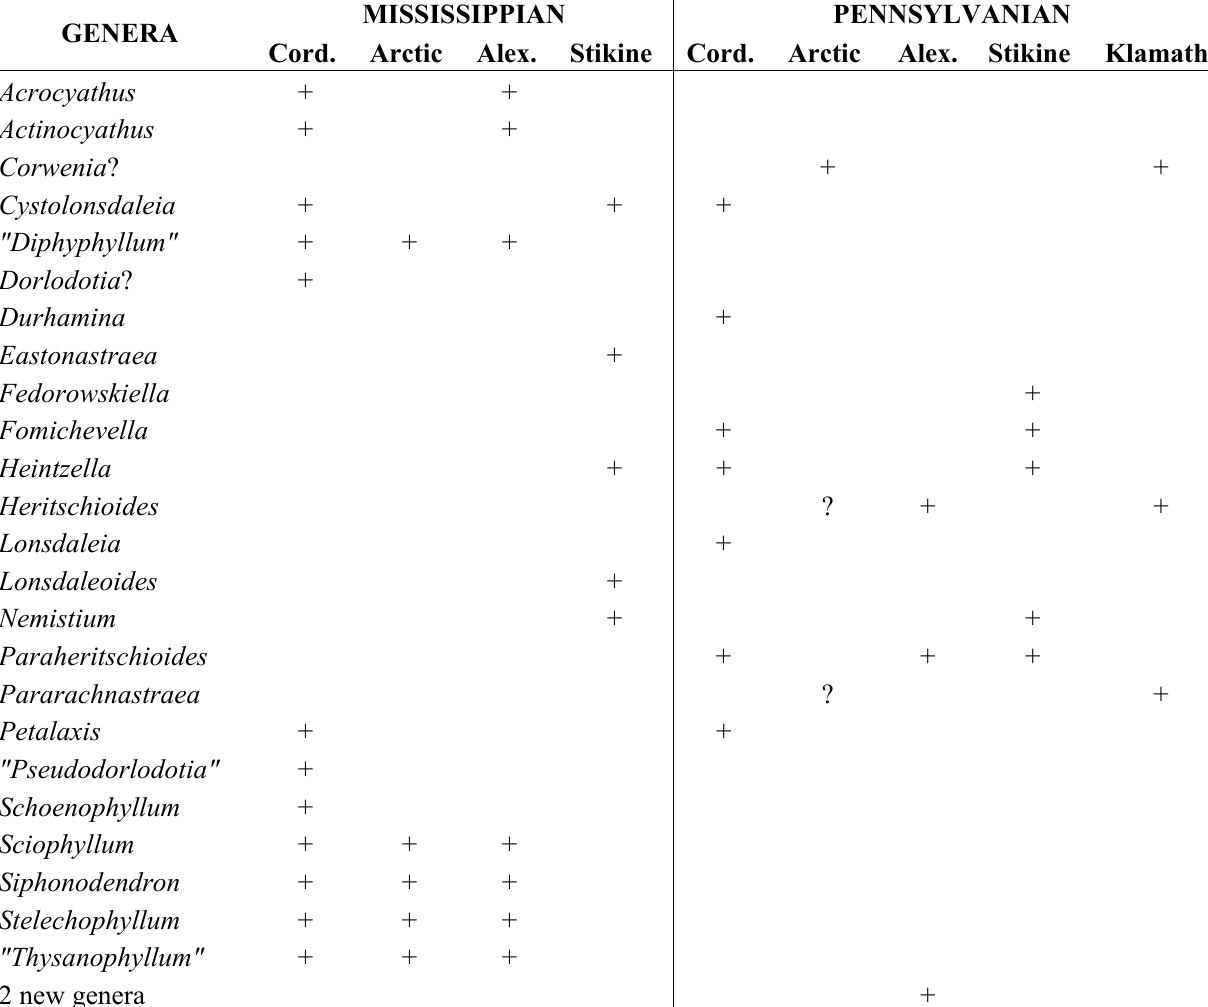
Table 1. Carboniferous Colonial Rugose Coral Genera. Cord = Cordilleran miogeocline; Arctic = Arctic Alaska; Alex = Alexander terrane; Stikine = Stikine terrane. GENERA